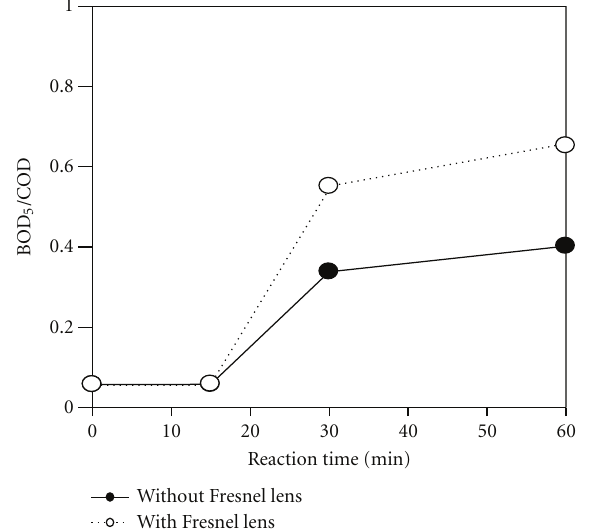
Figure 4: E ff ect of Fresnel lens on the biodegradability of color filter wastewater in solar photo-Fenton process (initial pH: 5.0; H 2 O 2 /COD = 1.25 g/g; [H 2 O 2 ] 0 /[Fe 2+ ] 0 = 15).